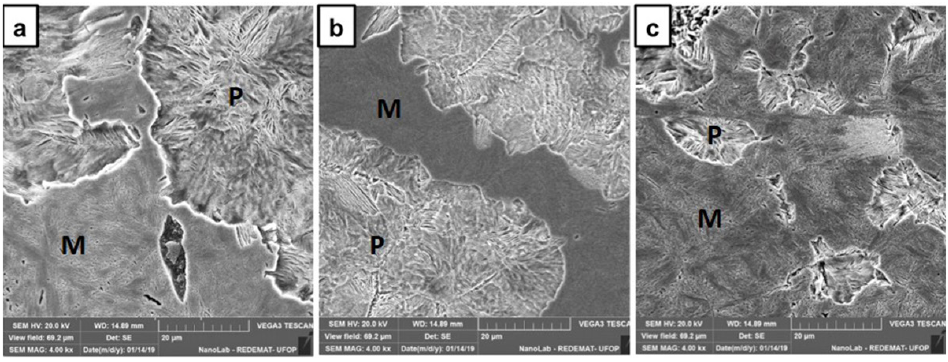
Figure 7. Micrographs of steels A (a), B (b) and C (c) submitted to 10 o C/s cooling rate - SEM - 4.000 X - 2% Nital etching (P – Pearlite, M – Table 4. Pearlite colony size, pearlite interlamellar spacing and Vickers microhardness of studied steels submitted to 0.5°C/s and 2.5 o C/s cooling rates; Vickers microhardness of samples submitted to 10 o C/s cooling rate. Rate Steel Pearlite colony size (µm) 0.5